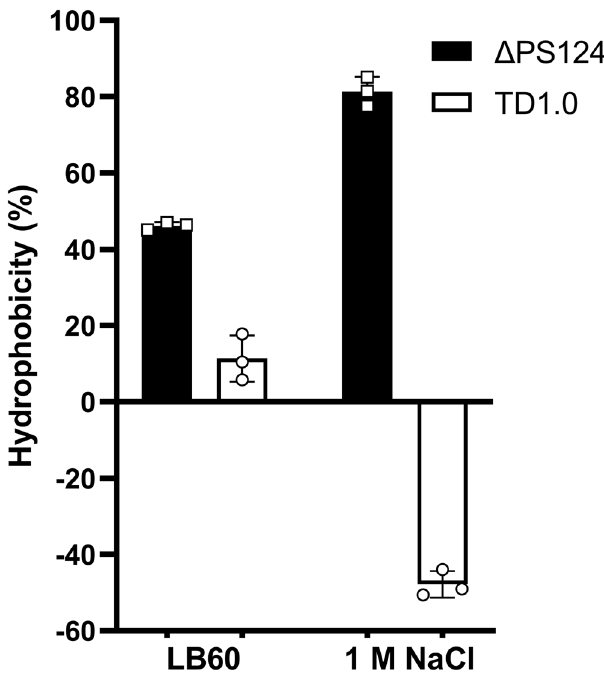
Fig. 5 Cell surface hydrophobicity of Δ PS124 and TD1.0 in LB60 medium or 1 M NaCl solution. LB60 medium contains 1 M NaCl. Data are shown from three biological replicates. Error bars are SD ( n = 3). TD1.0, H . bluephagenesis TD1.0; Δ PS124, H . bluephagenesis TD1.0 with deletion of PS1, PS2 and PS4 gene clusters.